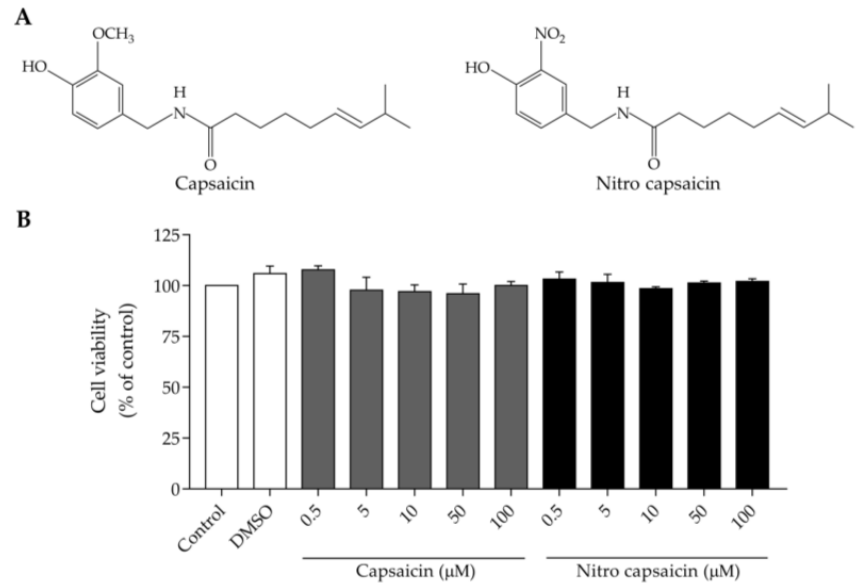
Figure 1. Effect of nitro capsaicin and capsaicin on SIMA9 cell viability. ( A ) Structure of the original compound (capsaicin) and the modified compound (nitro capsaicin); ( B ) Viability of SIMA9 cells after exposure to different concentrations of nitro capsaicin and capsaicin for 24 h ( n = 3). 3.2. Nitro Capsaicin Inhibited Nitric Oxide Production, iNOS Expression, and NF- κ B Activation in SIMA9